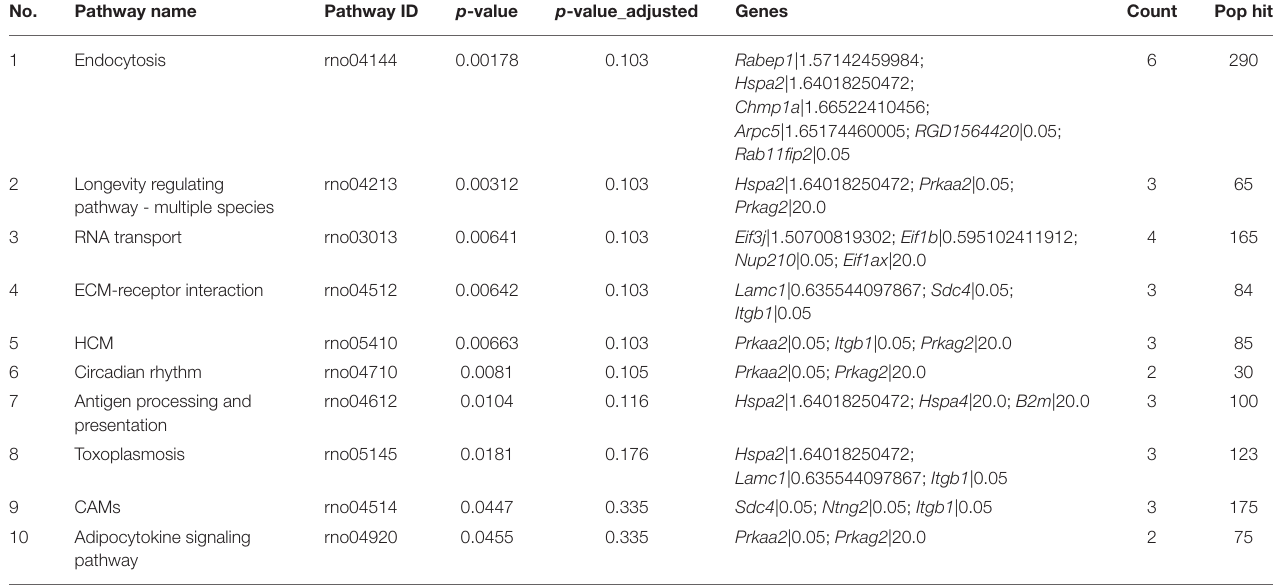
TABLE 5 | KEGG pathway annotation list ( n =